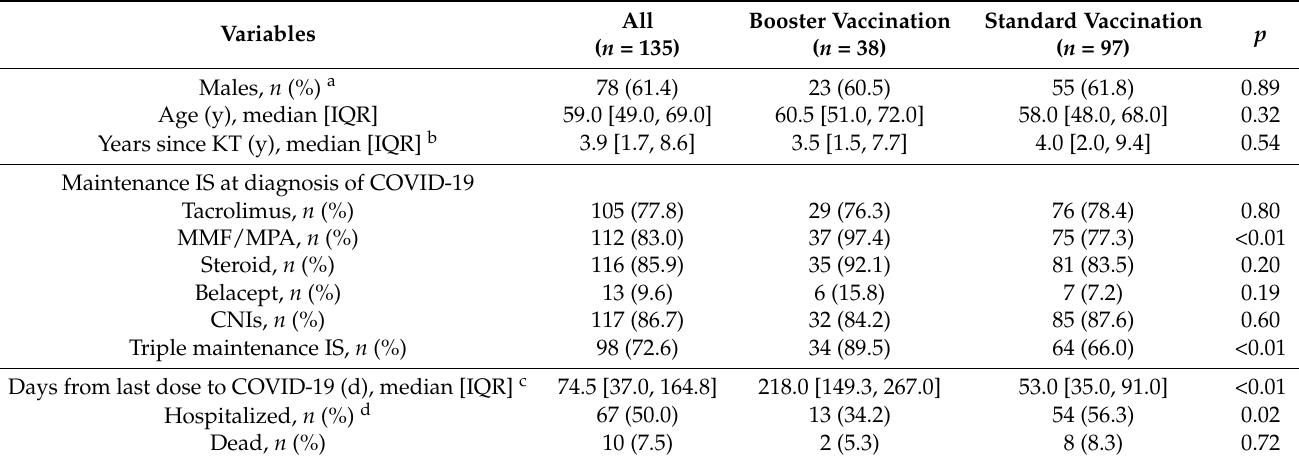
Figure 1. COVID-19 breakthrough infections in vaccinated kidney transplant recipients. Table 3. Comparison between KTRs who received standard vaccination and those who received booster vaccination.